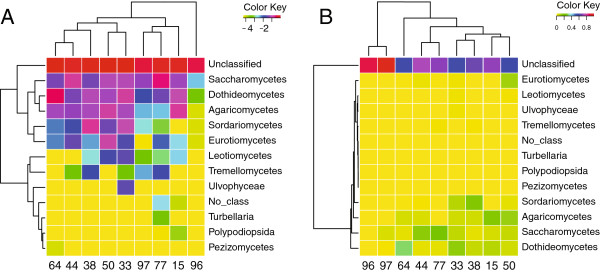
CloVR-ITS heatmap clustering visualizations for gastric fluid data. CloVR-ITS outputs hierarchical clusterings of samples and annotations at several taxonomic levels. These clusterings are computed utilizing the furthest-neighbor algorithm with a Euclidean-distance metric on either log-transformed proportions or simple proportions of taxon groups, shown at the class level in (A) and (B), respectively. While proportions alone help the user assess the overall distribution of taxonomic assignments for each sample, log-transformed proportions can be useful for visualizing similarities or differences between samples that affect members of the community that may make up less than 1% of the total sequences in a sample. Clusterings did not demonstrate significant associations among gastric fluid samples from subjects with similar treatments or conditions (see Additional file 2: Table S1 for sample metadata).